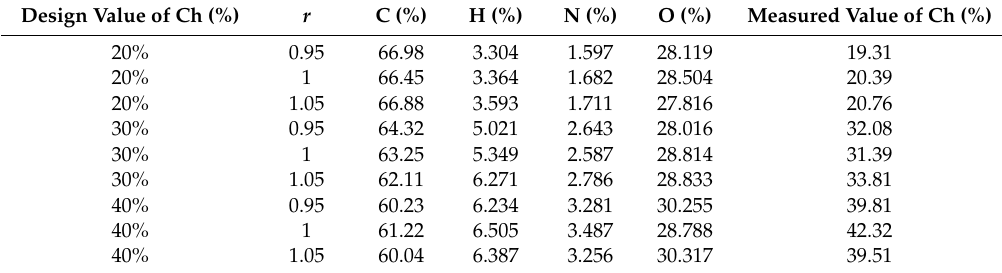
Table 3. Element analysis of synthetic polyester-based TPUs.